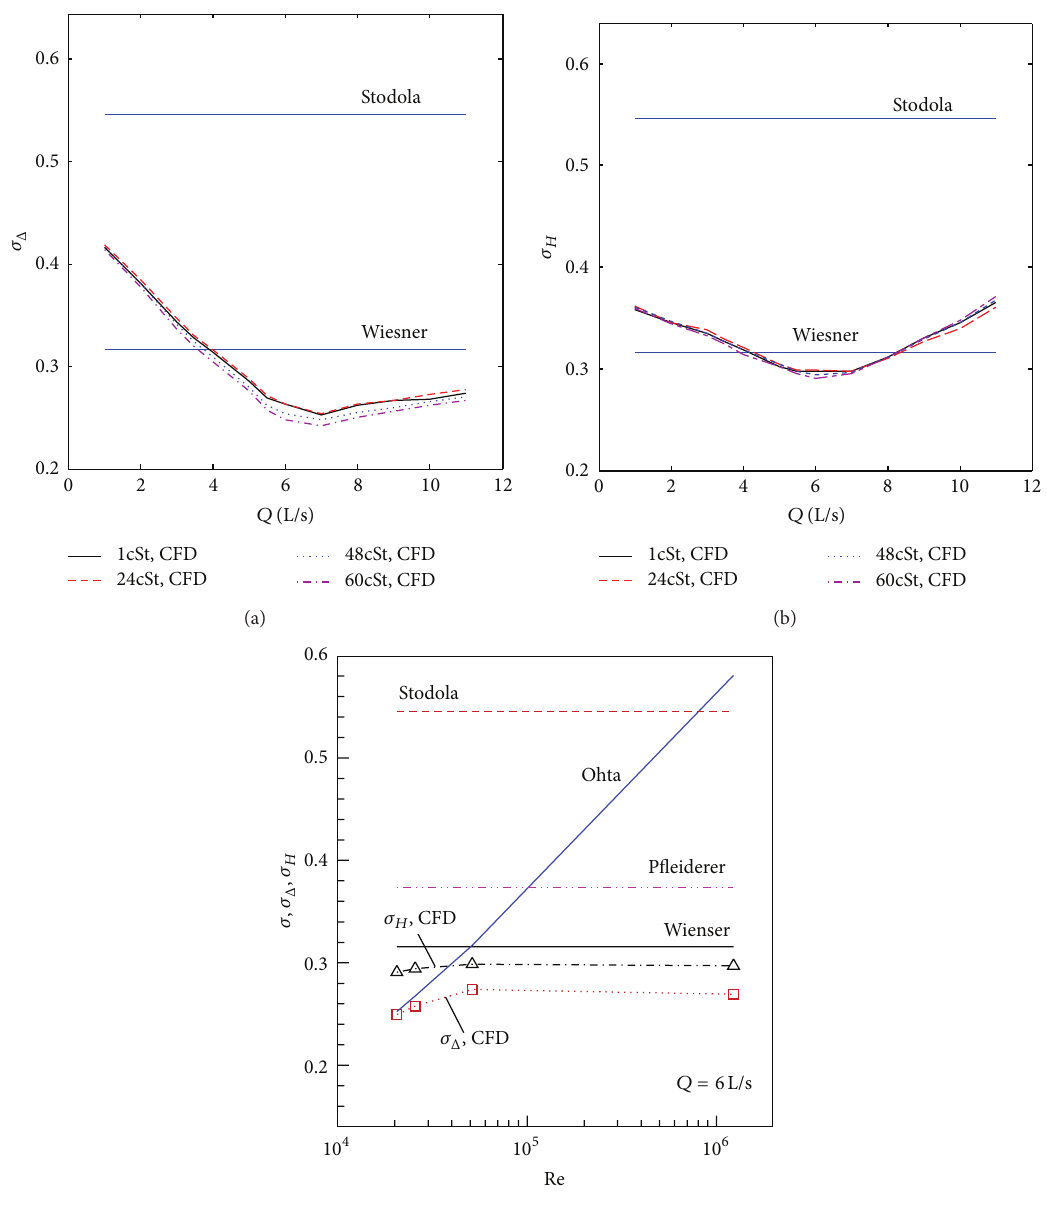
Figure 10: Various slip factors in terms of flow rate and Reynolds number at BEP for impeller with 𝛽 2𝑏 = 44 ∘ , (a) based on velocity triangle at impeller outlet, (b) from impeller theoretical head of 3D viscous flow, (c) at